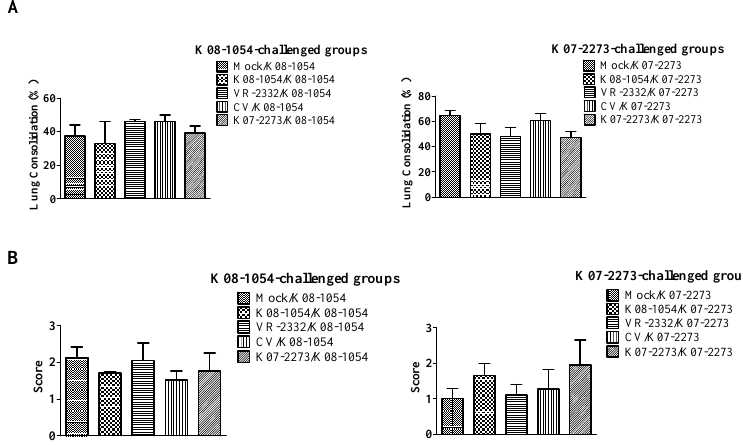
Figure 8. Evaluation of gross and microscopic lung lesions in pigs at 42 dpv. Gross ( A ) and microscopic ( B ) lung scores were recorded after necropsy. Lung scores were plotted as the mean lesion score values from three pigs in each group, and the error bars represent the standard error of the mean (SEM).